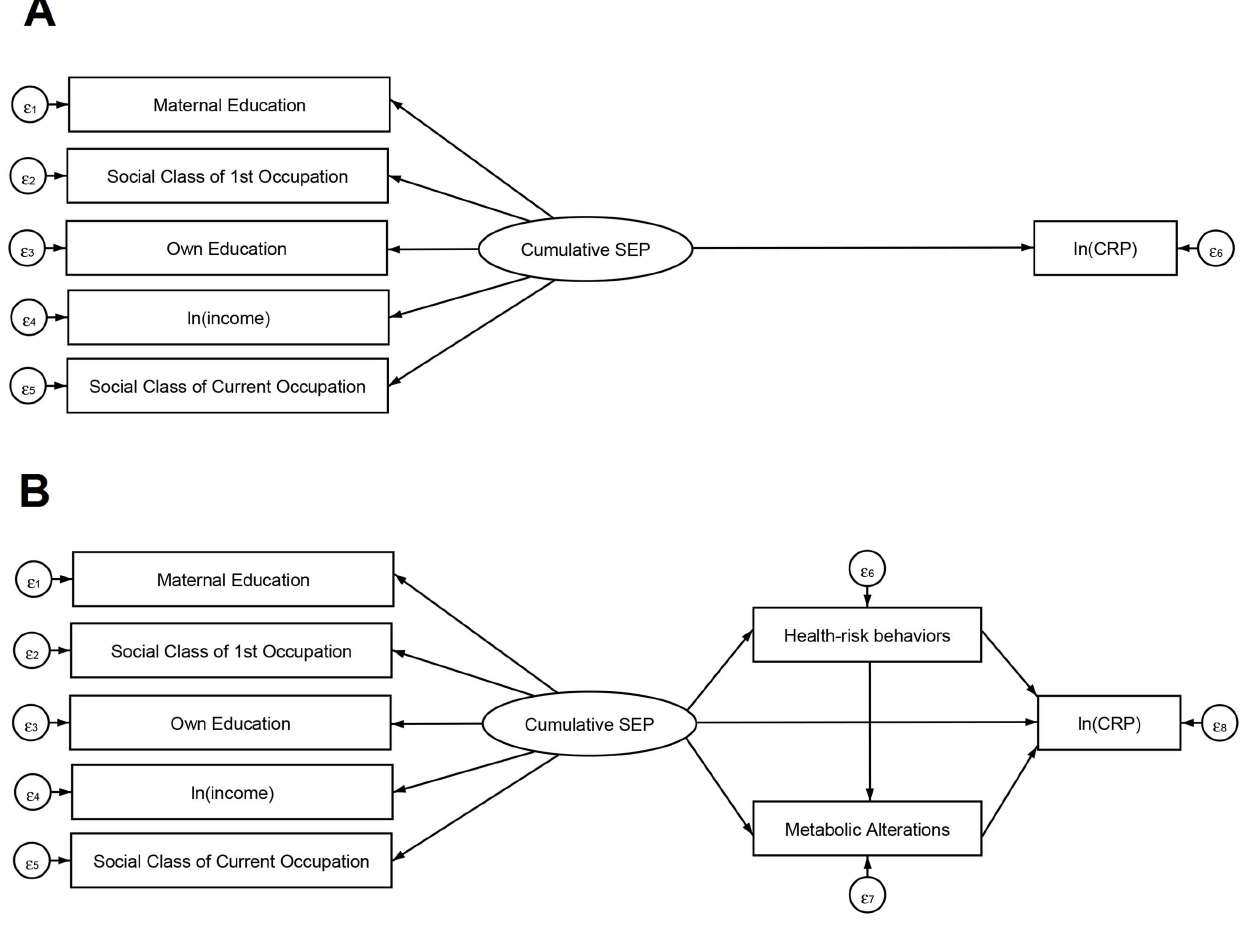
Figure 1. Illustration of proposed multiple mediation of the association between life course SEP and CRP. (A) Total effect of life course SEP on CRP. (B) Hypothesized indirect effect of SEP on CRP through mediators and direct effect. Brazilian Longitudinal Study of Adult Health (ELSA- Brasil), 2008–2010.